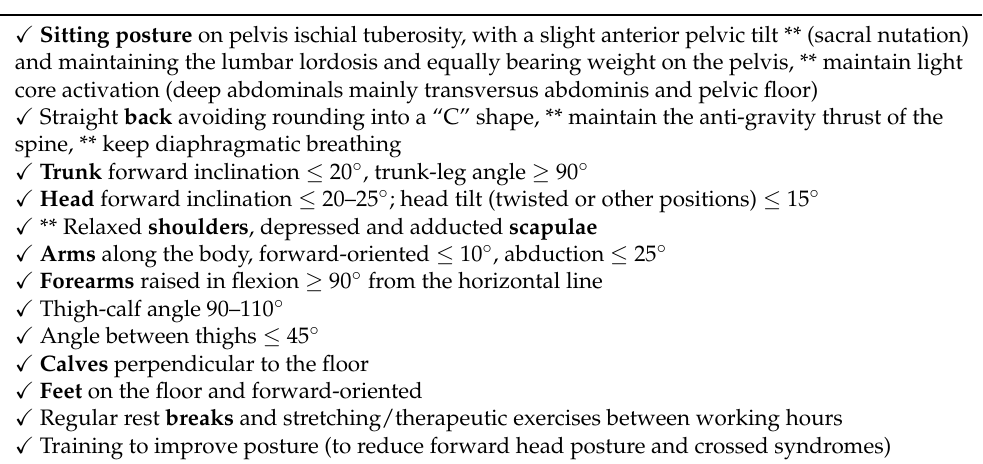
Table 1. Working posture for dental professionals